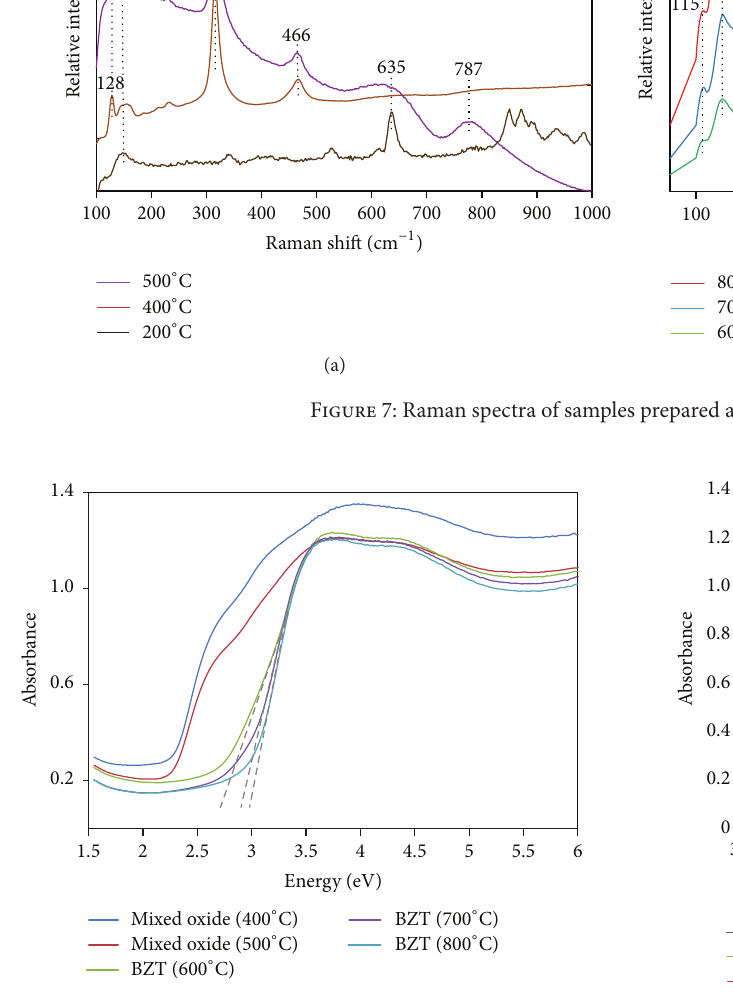
Figure 8: UV-Vis spectra of powder samples prepared at various temperatures. Figure 9: AO7 dye absorption curves ( 𝜆